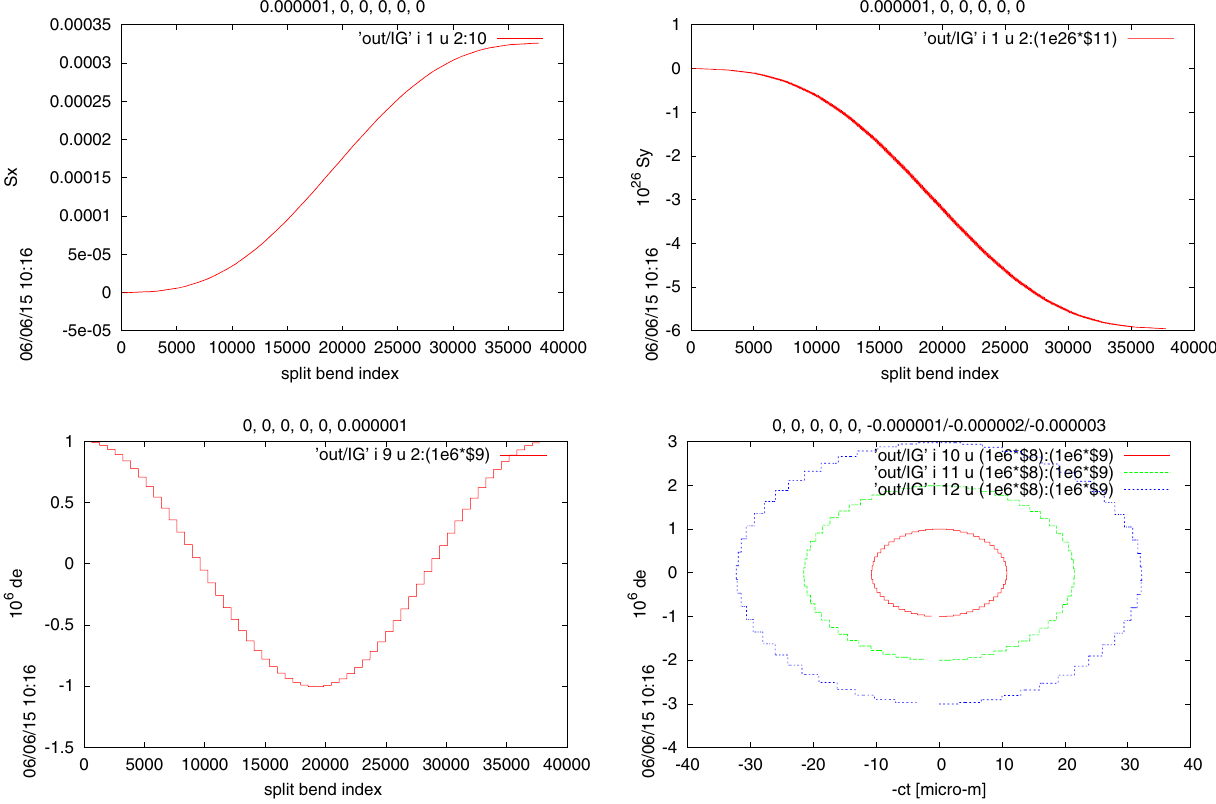
FIG. 5. The upper plots show the s x and s y spin components of a single electron, with initial horizontal amplitude xtyp ¼ 1 e- 6 m, in the AGS analog ring. (The 6D initial conditions are given above the plots.) The horizontal axis “ split bend index ” increases by 1 at each bend, of which there are 640, so about 59 turns are shown. The lower right figure shows longitudinal phase space evolution for three off- energy particles, with energy offset de plotted against time offset − ct . One sees that almost exactly one revolution is completed during this time. The synchrotron tune is therefore approximately 1 = 59 . The lower left plot shows the de energy deviation during one synchrotron oscillation